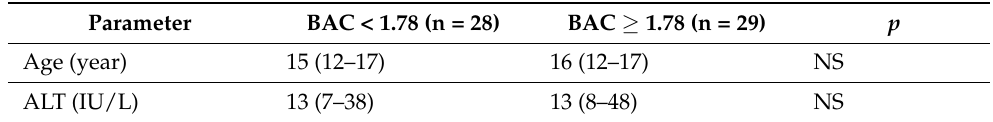
Table 3. Characteristics of the study group in terms of